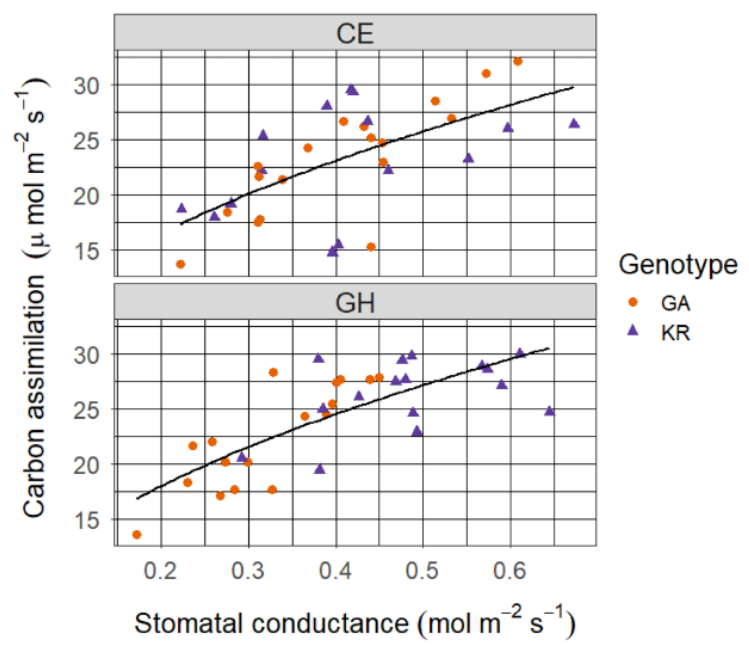
Figure 2. The same curvilinear relationship ( A ~ √ ( g s )) between leaf-level CO 2 assimilation ( A ) and stomatal conductance ( g s ) was consistent across two wheat cultivars (KR, Krichauff; GA, Gatsby) grown in the glasshouse (GH) or controlled environment (CE) chamber. Gas exchange was measured at 400 μmol mol −1 CO 2 , PPFD = 1800 μmol m −2 s −1 , and 26 °C (block temp). Each data point represents a single biological replicate and points are colored by genotype. R 2 = 0.78, p < 0.001.